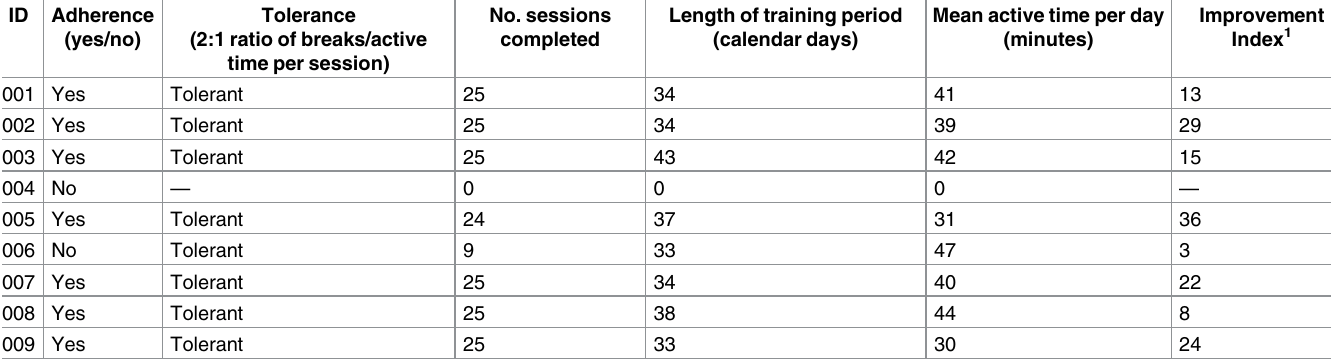
Table 3. Feasibility outcomes on Cogmed QM for all participants (N =